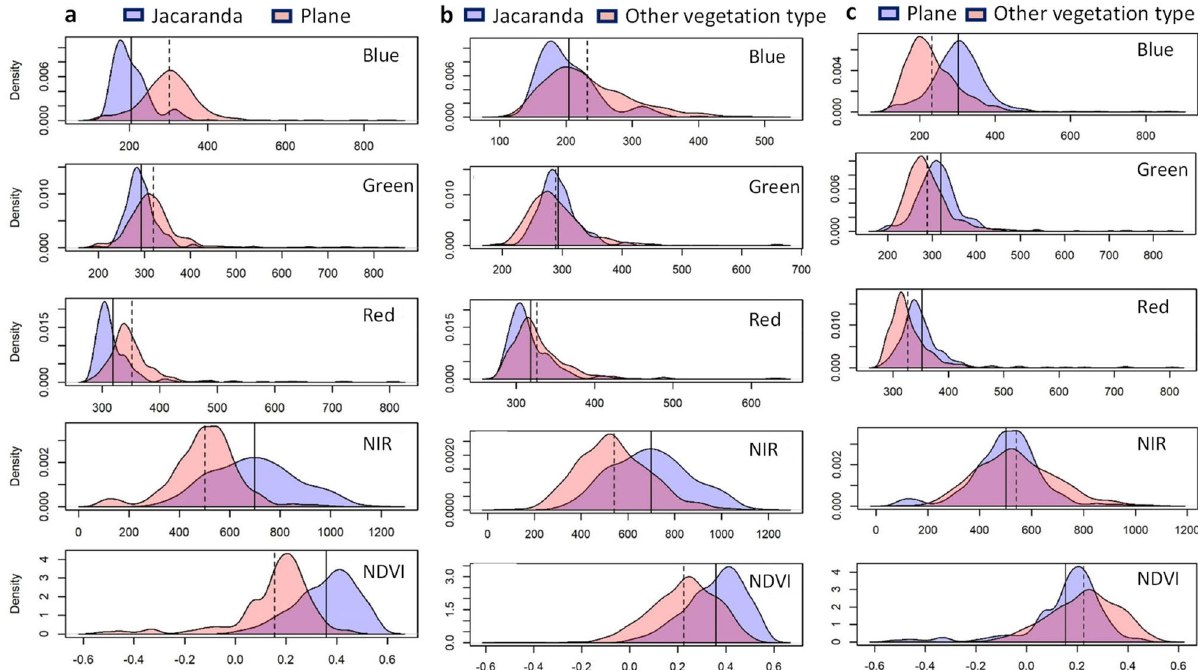
Figure 3. The distribution of the data for each of the paired three classes of trees and other vegetation ( a ) Jacaranda versus Plane, ( b ) Jacaranda versus other vegetation type and ( c ) plane versus other vegetation type, in the four bands (Blue, green, red and NIR) and NDVI index. Histograms with the least spectral overlap between each of the paired classes show the best separability between them. The different spectral bands and vegetative indices were generated using the ArcGIS desktop software version 10.3 from SPOT 6 pan-sharpened images obtained from the South African National Space Agency (SANSA).